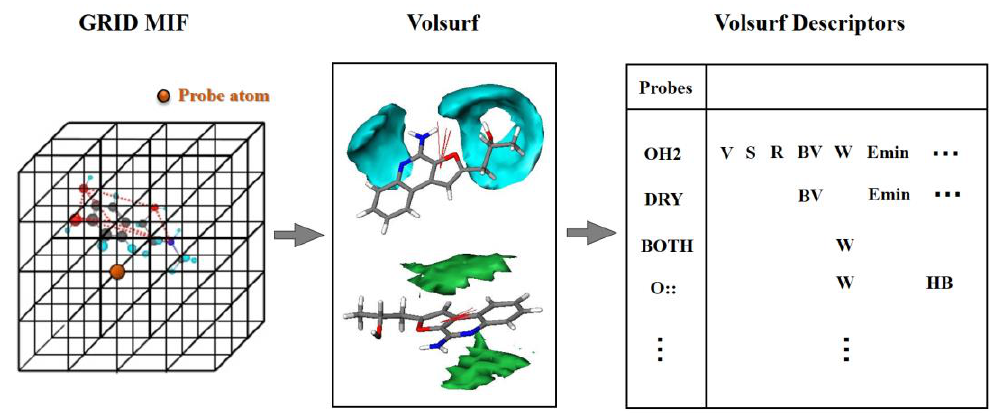
Figure 8. The procedure of VolSurf description: (1) dividing the molecular space into 3D lattice points; (2) calculating the interaction energies of molecules by specific probes in each lattice point; (3) quantitating the interaction volume and surface information. MIF: molecular interaction fields.